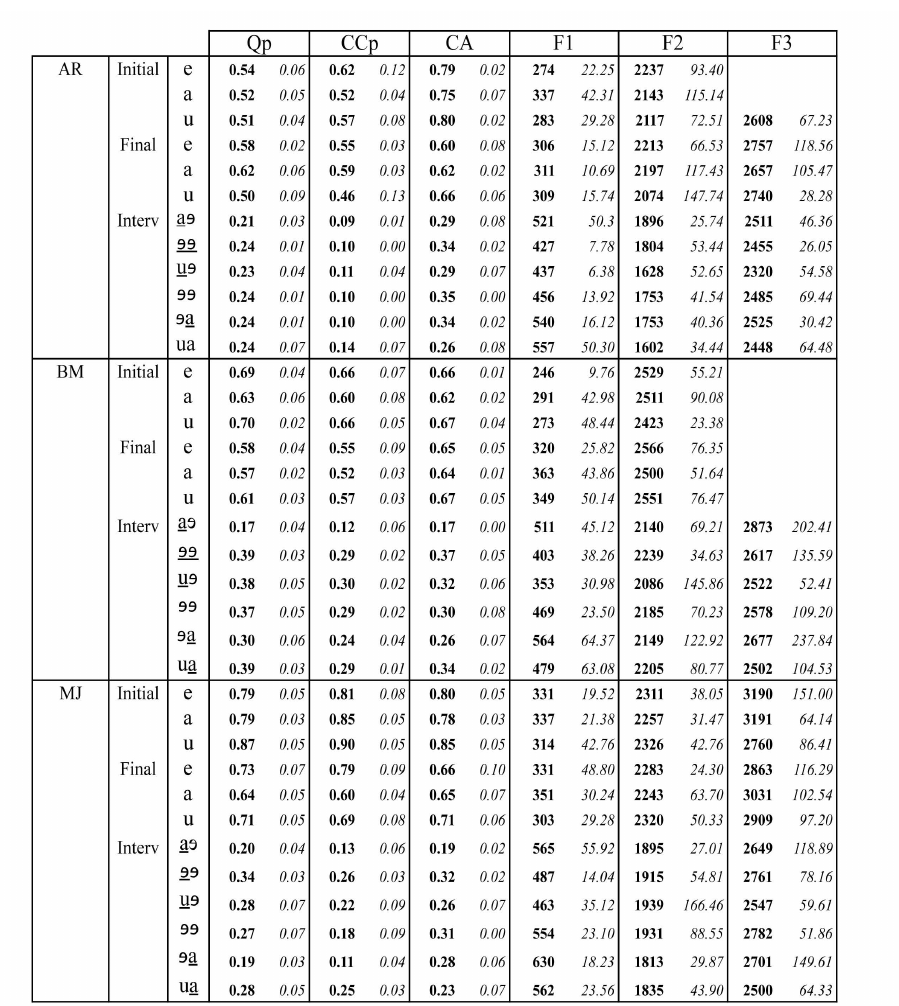
TABLE II. Qp, CCp, CA, F1, F2 and F3 values for initial, final and intervocalic [j] for each speaker and across speakers. Means across repetitions are given in boldface, and standard deviations appear in italics. Stressed vowels in the [VjV] sequences appear underlined. F3 values may be absent or unaccompanied by standard deviations if corresponding to a single